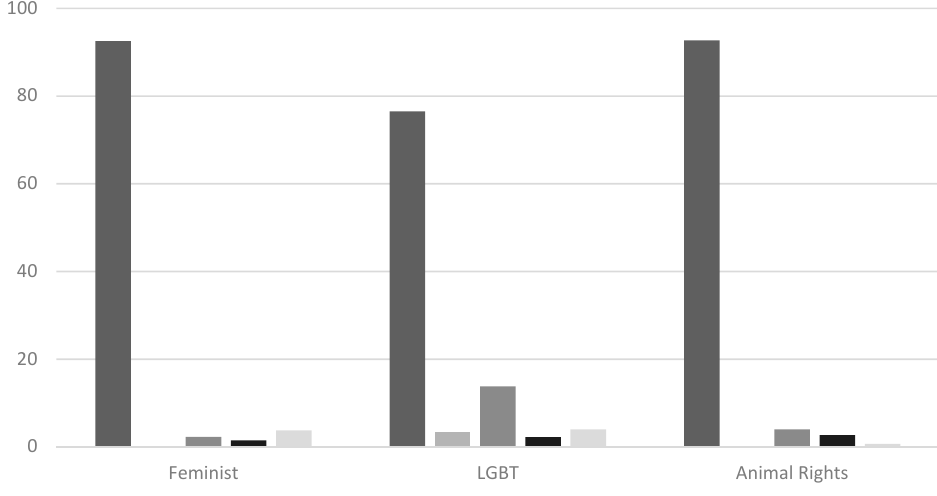
Figure 5. Distribution of Body Type.